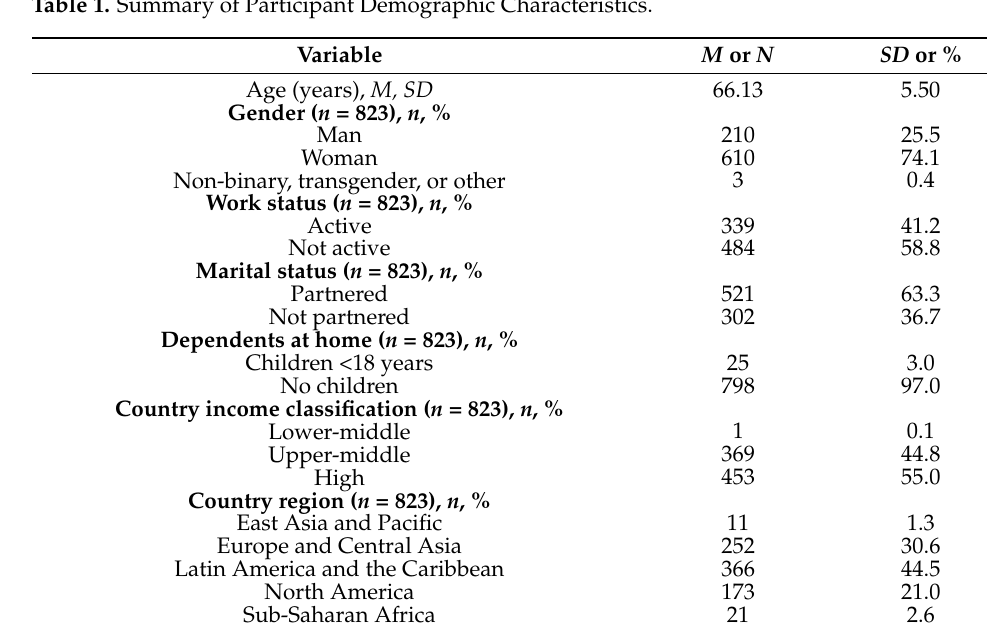
Figure 1. Flowchart of participant inclusion/exclusion process. Table 1. Summary of Participant Demographic